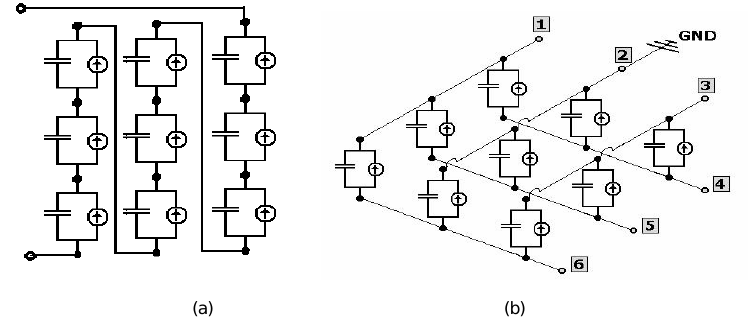
Fig. 2. Circuit model of sensors showing (a) a continuous sensor array and (b) a cross-sensor